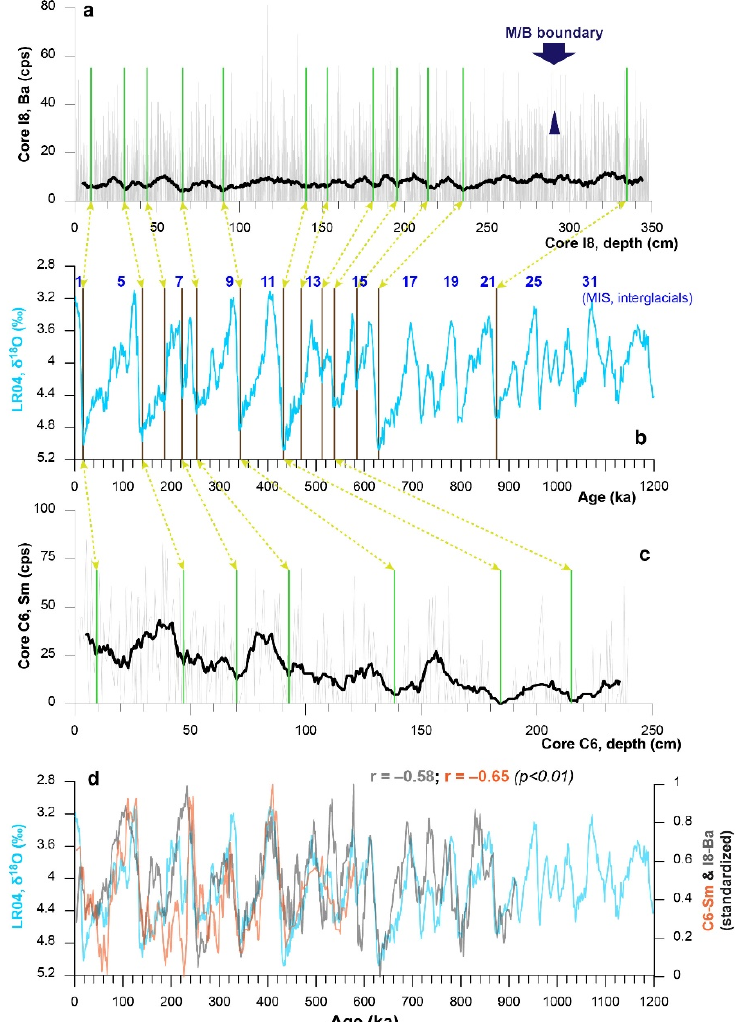
Figure 3. Tuning element intensities to LR04 δ 18 O record. ( a ) Ba record with 81-point moving average of core I8 on depth scale; ( b ) Benthic δ 18 O stack LR04 [2]; ( c ) Sm record with 15-point moving average of core C6 on depth scale; thin lines, original records; bold lines, the moving average. ( d ) Comparison between element intensities of the two studied cores and LR04 records on glacial–interglacial timescales. The arrows between ( a – c ) represent the correlations, and these data are listed in Table 1.